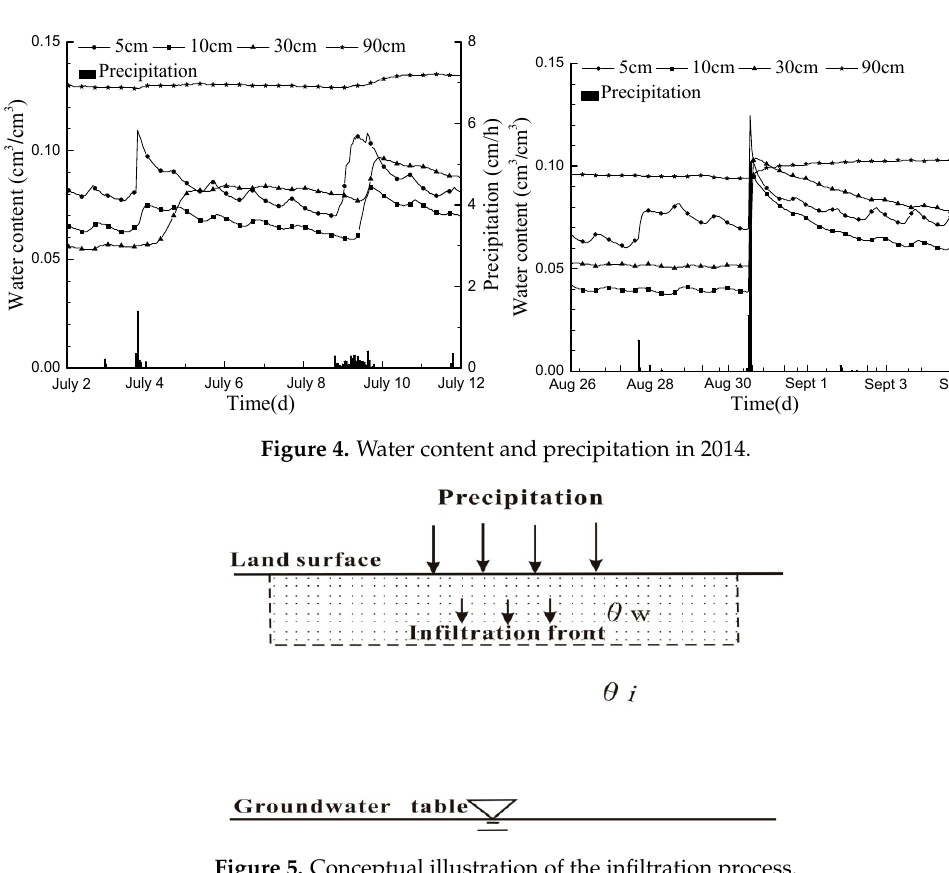
Figure 5. Conceptual illustration of the infiltration process.